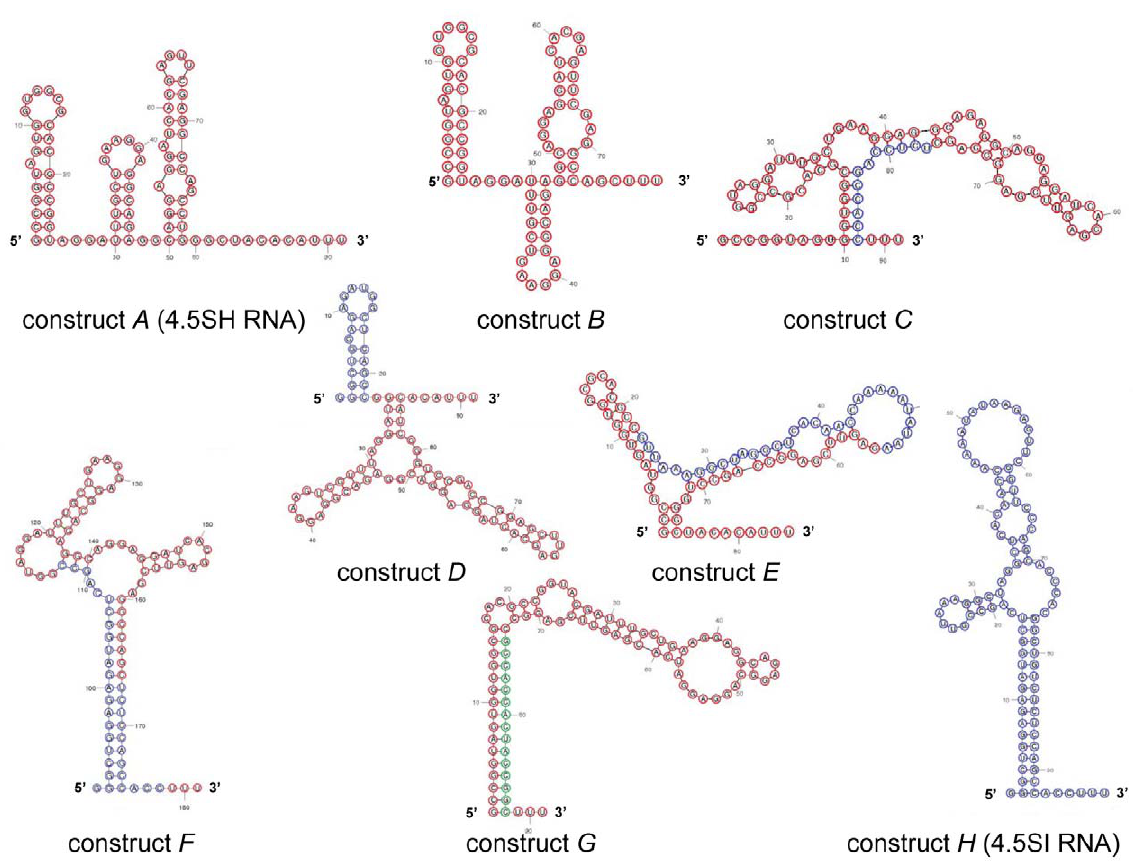
Figure 5. Predicted secondary structures of 4.5SH RNA ( A ) and its derivatives ( B–G ) as well as 4.5SI RNA ( H ). 4.5SH- and 4.5SI-derived nucleotides are marked by red and blue circles. Nucleotides of altered sequences are marked by green circles.